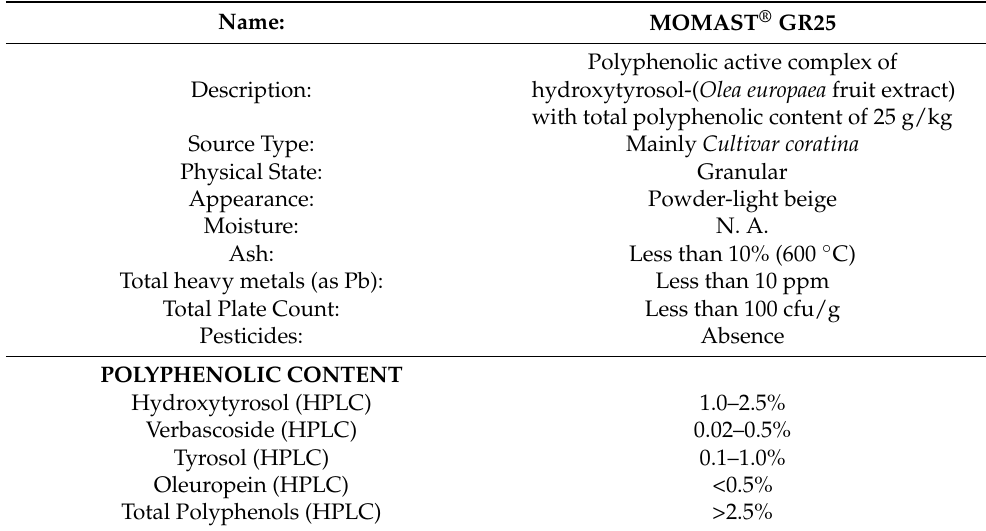
Table 1. Characteristics of the Polyphenolic Complex MOMAST ®